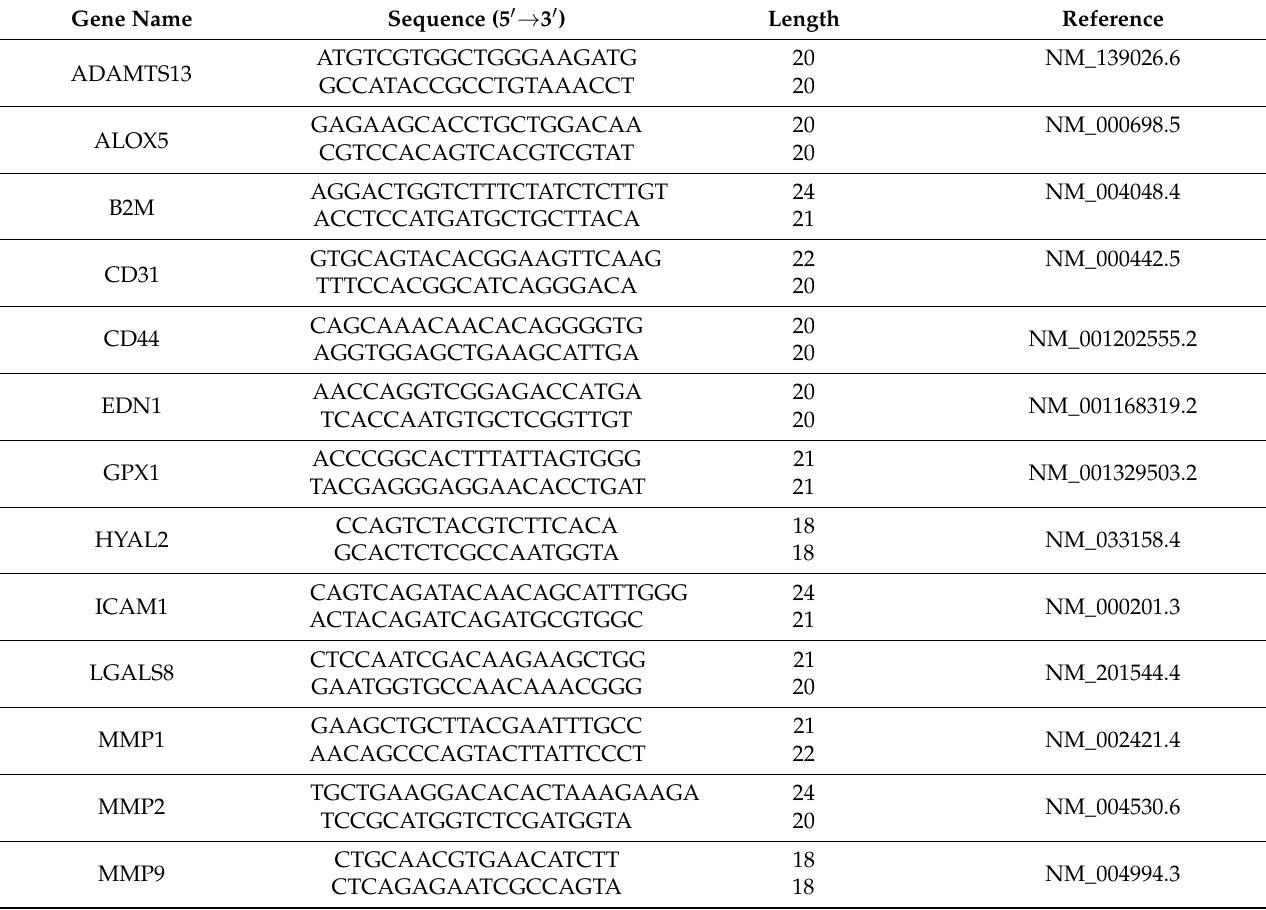
Table 2. DNA oligonucleotide sequences used for